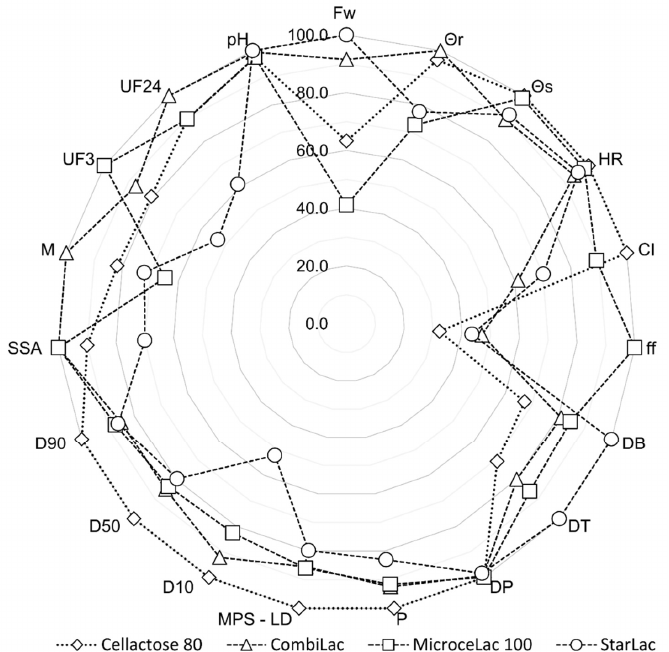
Figure 3. Physical characteristics of CPEs. Fw—flow through the orifice; θ r—angle of repose (tg α ); CI—compressibility index; DB—bulk density; DT—tapped density; DP—pycnometric density;